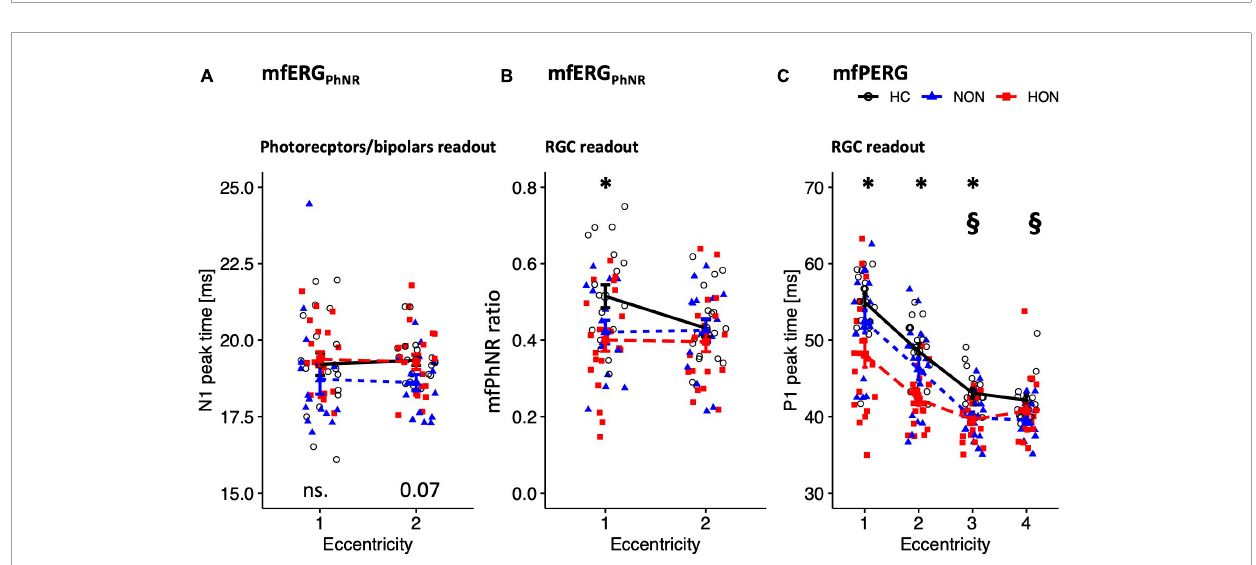
FIGURE3 Functional readouts eccentricity-based analysis depicted as mean ± SEM. (A,B) mfERG PhNR stimulation spanning two eccentricities: (A) N1 peak time. (B) mfPhNR ratio. (C) mfPERG P1 peak times across four eccentricities. For legends, see Table 3 . P -values of comparative analysis across the three groups are displayed along the x axis for each measure. ∗ Indicates significant HON vs. HC differences. § Indicates significant NON vs. HC differences.